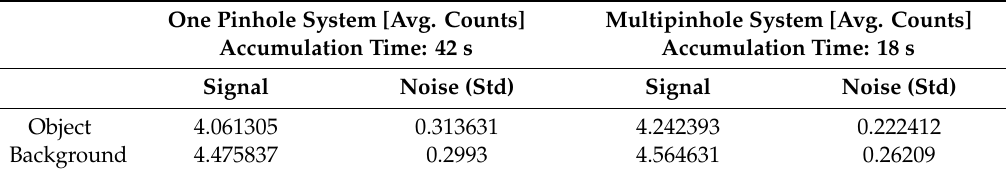
Figure 8. Coin test results—comparing scan time of the two systems: ( a ) one pinhole system with a coin not recognized after short accumulation time (18 s scan); ( b ) one pinhole system image obtained with long accumulation time (42 s scan); ( c ) the recognized coin in the variable multipinhole array system after short accumulation time (18 s scan); ( d , e ) reconstructed image in the variable multipinhole array system after dome effect correction. Table 2. Calculated experiment results—SNR: systems’ SNR comparison of coin images with short accumulation time.